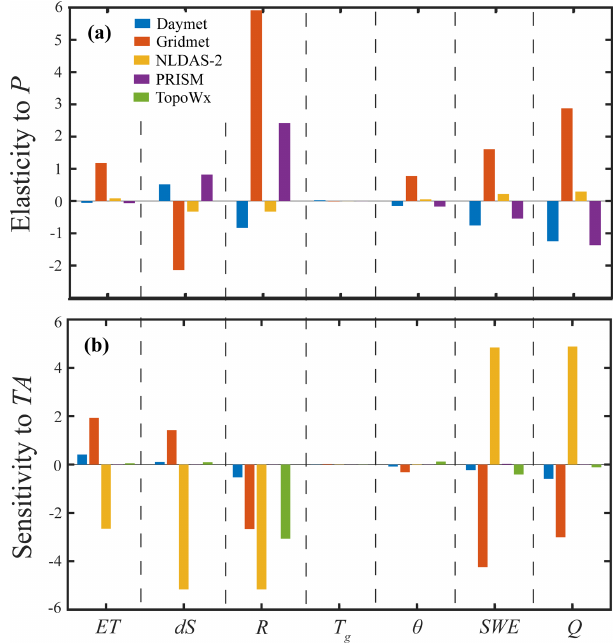
Figure 13. Elasticity (a) and sensitivity (a) of simulated hydro- logic variables evapotranspiration (ET), change in subsurface stor- age (d S ), potential recharge ( R) , land surface temperature ( T g ) , root zone soil moisture ( θ) , snow water equivalent (SWE), and streamflow ( Q) to variability in precipitation and air temperature for WY2016. Each bar represents the average value from the Kaweah River watershed, except streamflow measured at the Kaweah Termi- nus dam. Elasticities were calculated using the scenarios from the VarPConstTA experiment, and sensitivities were calculated using the scenarios from the ConstPVarTA